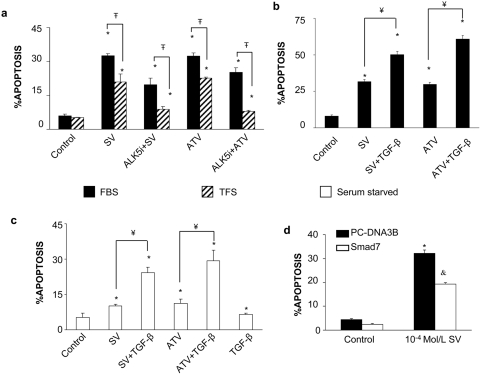
TGF-β mediates statins-induced VSMC apoptosis in 10% FBS.a. VSMCs were incubated with heat inactivated 10% FBS media or with 10% TGF-β-free FBS. Cells were treated with 10−4 Mol/L of Simvastatin (SV) or atorvastatin (ATV) for 48h. Some cells were preincubated for 1h with 10−5 Mol/L of the TGF-β type I receptor ALK5 inhibitor (ALK5i) before simvastatin or atorvastatin treatment. Black bars represent FBS treated cells; striped bars, cells in TGF-β-free FBS. *p<0.05 vs. control. ∓ p<0.05 vs. TFS. b. TGF-β increases statin-induced VSMC apoptosis. VSMCs were incubated with 10% FBS media. Cells were treated with 10−4 Mol/L of Simvastatin (SV) or atorvastatin (ATV) for 48h, some cells were stimulated with 10ng/mL of TGF-β. *p<0.05 vs. control. ¥ p<0.05 vs. 10−4 Mol/L SV. c. TGF-β increases statin-induced VSMC apoptosis in serum-free medium. Serum starved cells were treated with 10−4 Mol/L of either Simvastatin (SV) or Atorvastatin (ATV) alone or in combination with 1ng/ml TGF-β for 48h in serum-free conditions. *p<0.05 vs. control. ¥ p<0.05 vs. 10−4 Mol/L SV. $ p<0.05 vs. 10−4 Mol/L SV+TGF-β. d. Smad pathway is involved in Simvastatin induced cell death. Cells grown in 10%FBS were transfected with either control PC-DNA3B plasmid, or with a Smad7 overexpressing vector for 24h. Then cells were treated for 48h with 10−4 mol/L Simvastatin. Figure a shows percentage of hypodiploid cells expressed as mean±SEM of 6 experiments. *p<0.05 vs. control &p<0.05 vs. pc-DNA3B transfected cells.